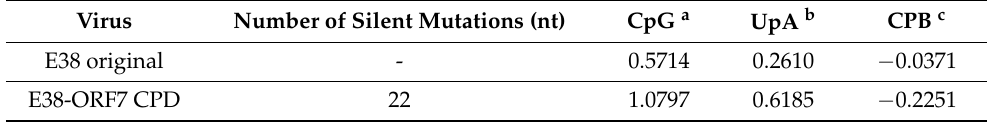
Table 3. Comparison of the E38 original virus and E38-ORF7 CPD.